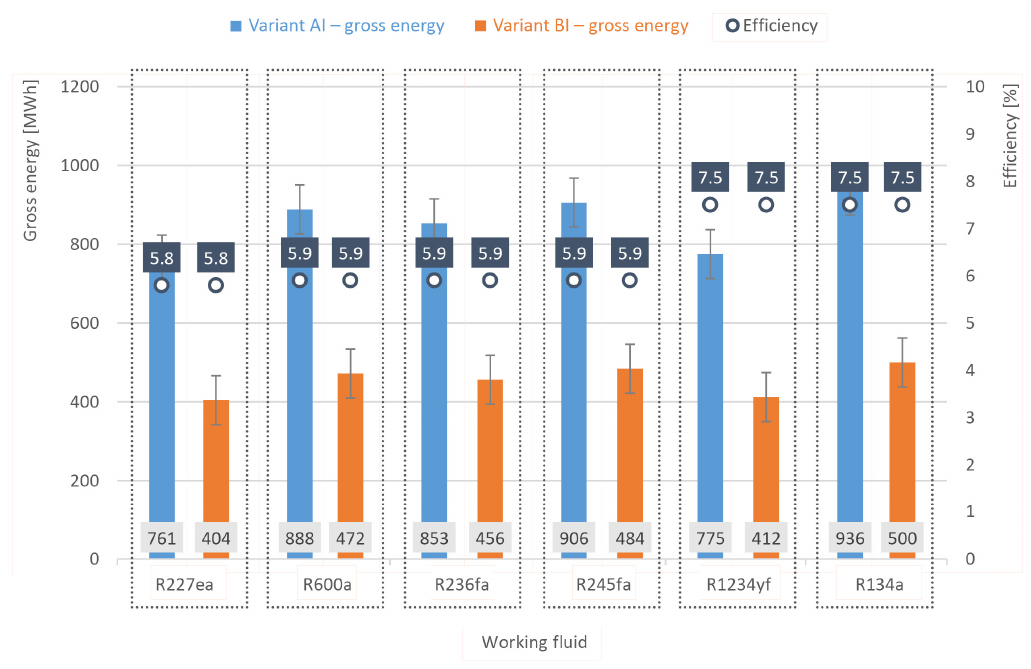
Figure 6. Comparison of the amount of electricity that can be produced in the AI and BI variants using ORC technology.